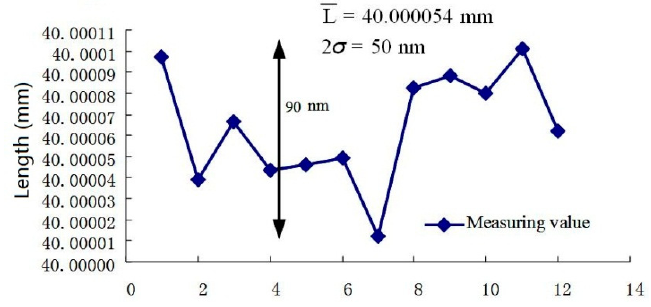
Figure 13. The measuring results of a sample gauge block.